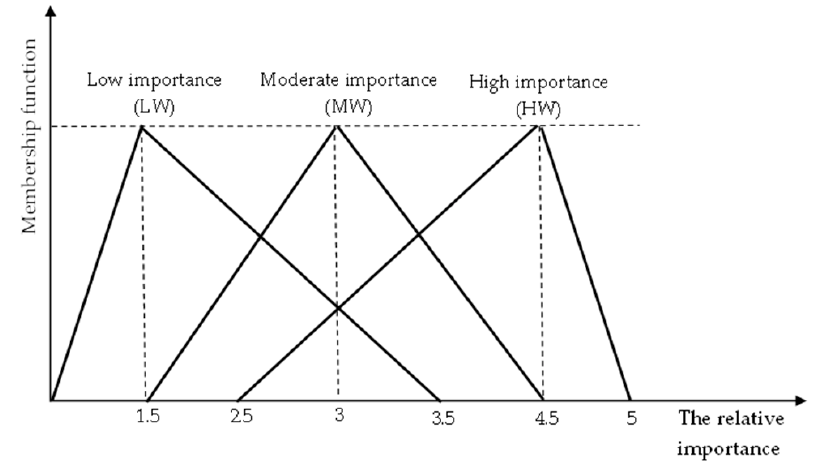
Figure 3. The TFNs describing the relative importance of RFs.